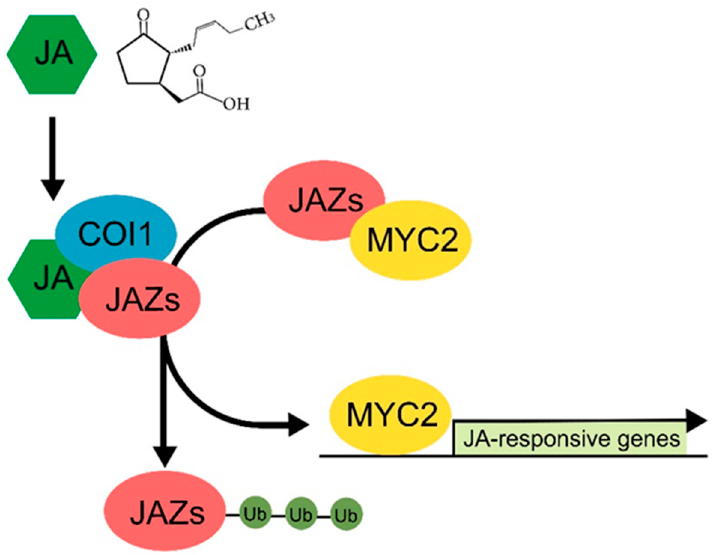
Figure 2. A schematic of JA signaling pathway. MYC2 is a key transcription factor responsible for expression of JA-responsive genes. In the absence of JA, the transcription activity of MYC2 is suppressed by direct interaction with JAZs. In JA condition, JA interacts with the JA receptor COI1 and provokes ubiquitin (Ub)-mediated proteolysis of JAZs, leading to activation of MYC2 and expression of JA-responsive genes.